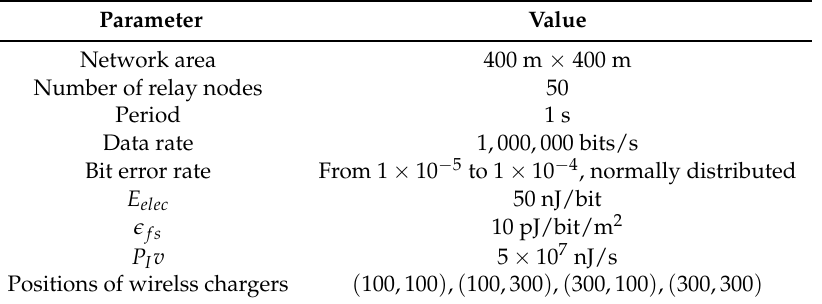
Figure 3. Simulation network topology. Table 1. The simulation